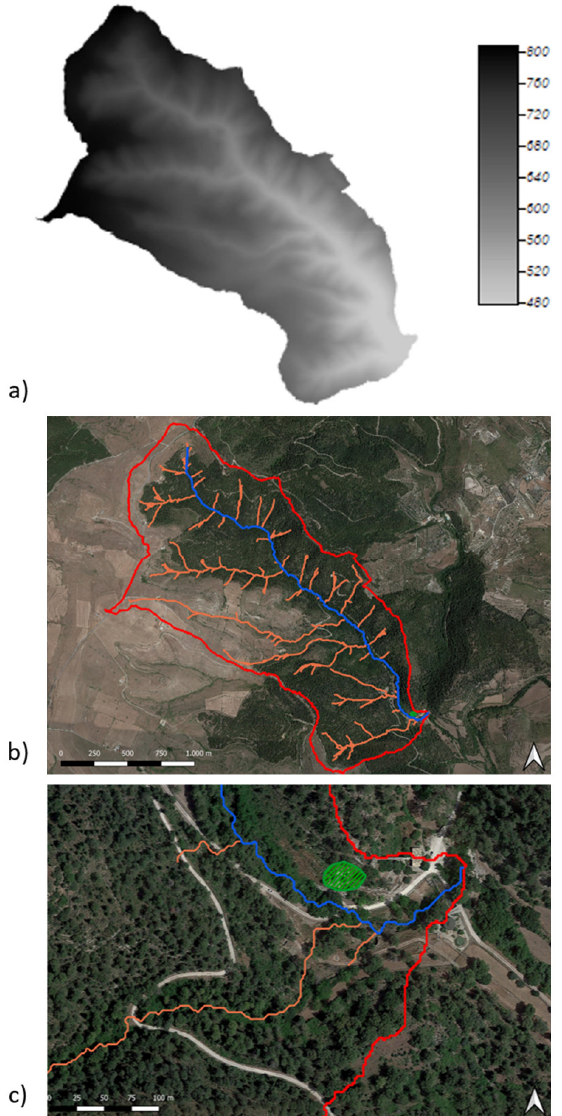
Figure 10 . Catchment area of the Calaforno hypogeum. a) analysed DTM; b) overall view of the basin and c) location of the Calaforno hypogeum, within the basin close to the closing section. In red the perimeter of the basin, in orange the hydrographic network, in blue the main shaft and in green the position of the